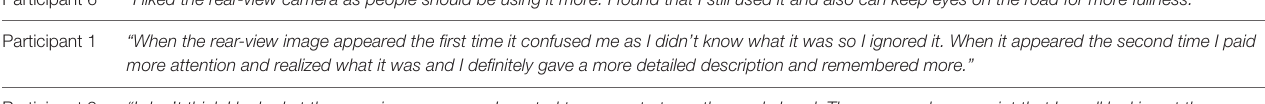
TABLE 6 | Attitudes to the presence or absence of the rear-view mirror in the videos as indicated in the debrief. Participant comments in the Debrief concerning the rear-view mirror Participant